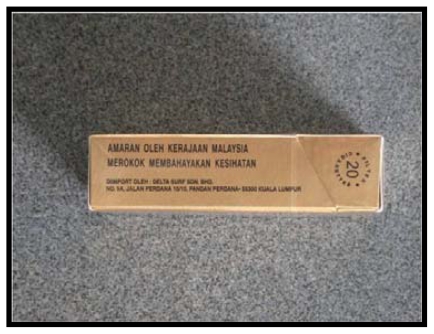
The text-only cigarette package warning label used in Malaysia before the implementation of the new labeling policy starting from January 2009.